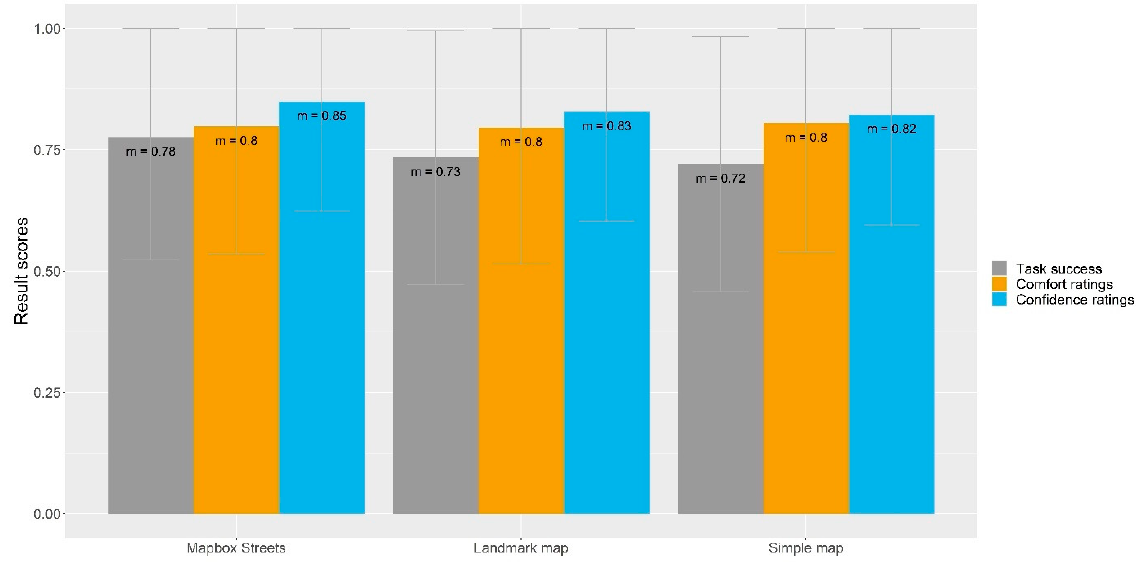
Figure 9. Task success, comfort, and confidence ratings by base map.